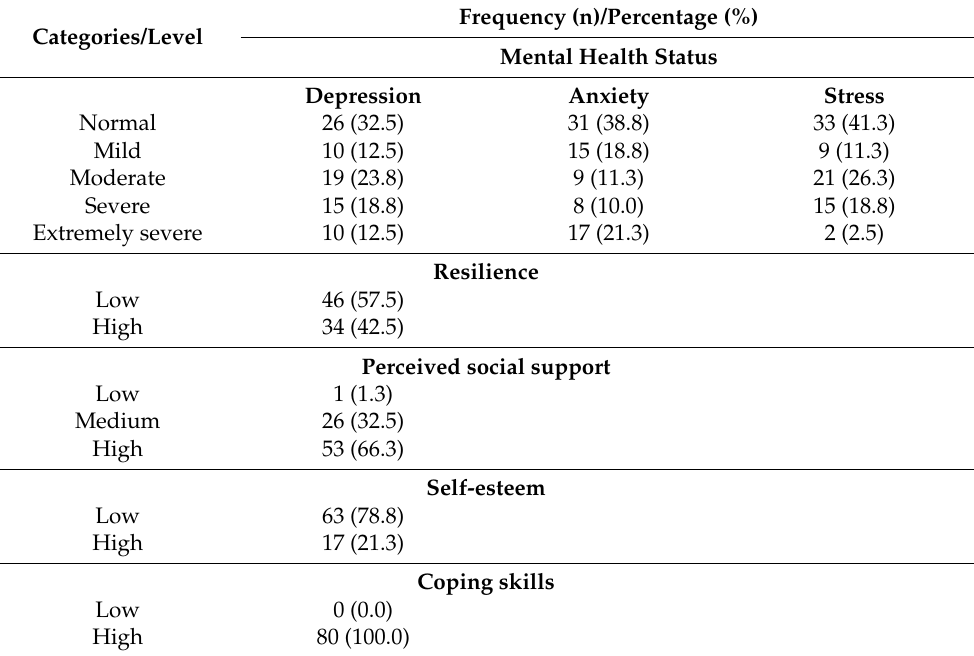
Table 3. Overall mental health status, resilience, perceived social support and self-esteem of partici- pants before intervention.